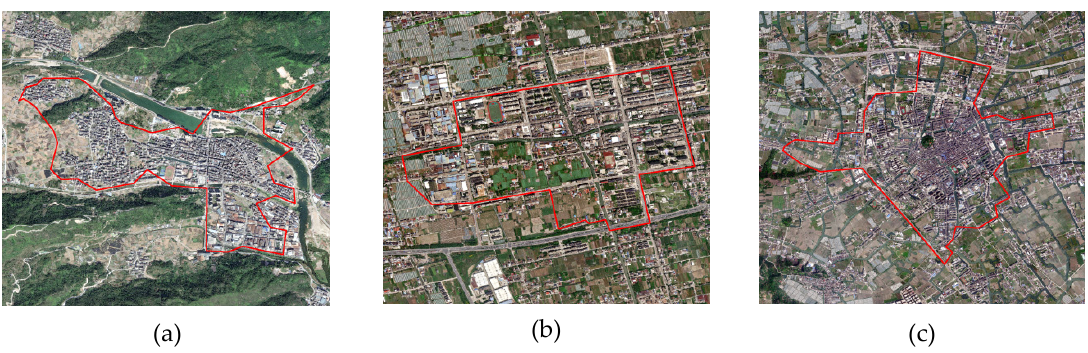
Figure 4. Some ordinary towns reach the size of larger town: ( a ) Furong town, ( b ) Pengjie town, and ( c ) Yishan town.